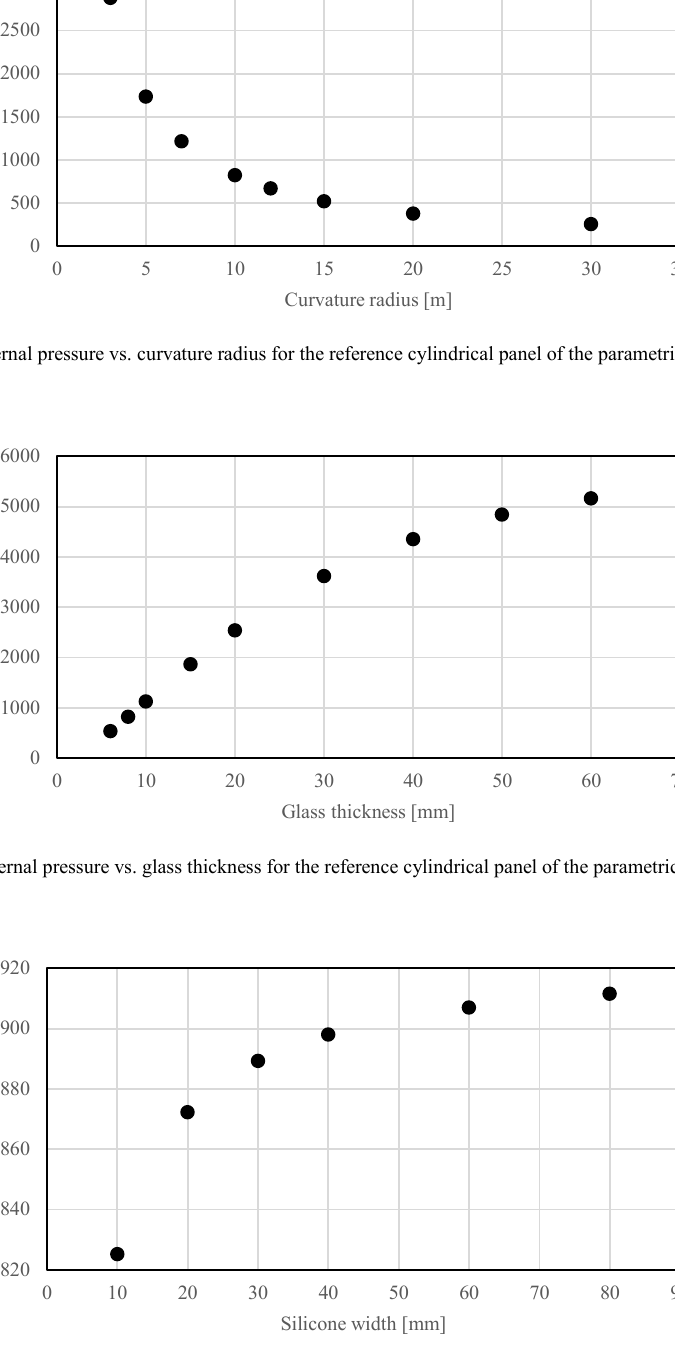
Fig. 5 Internal pressure vs. sealant silicone bite for the reference cylindrical panel of the parametric